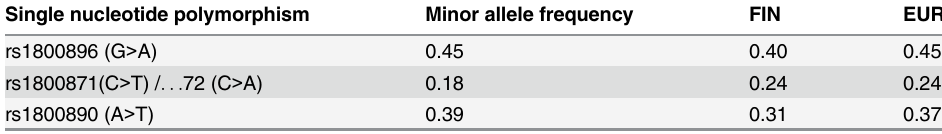
Table 1. Minor allele frequencies of the studied IL-10 polymorphisms and comparison to population genetics. Single nucleotide polymorphism